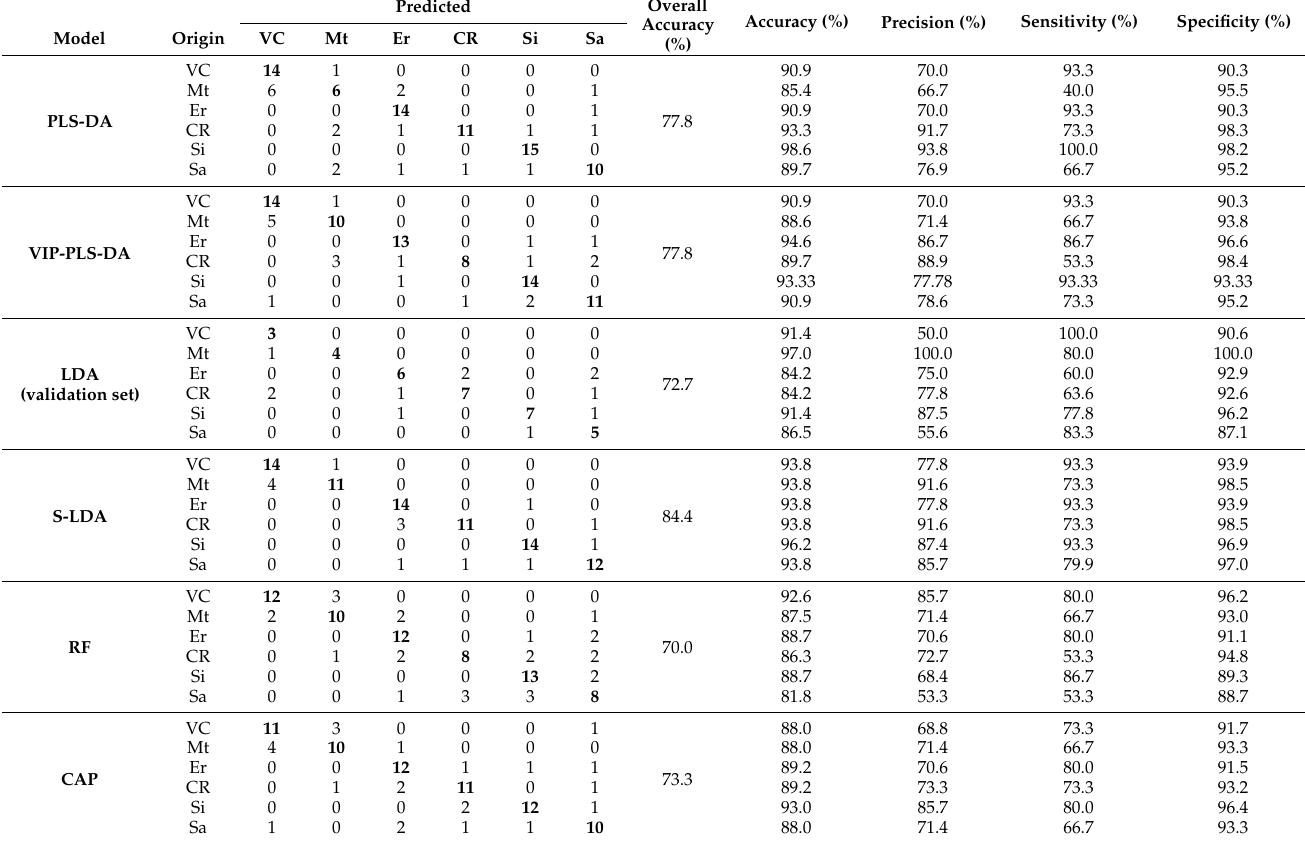
Table 1. Partial least-squares discriminant analysis (PLS-DA), variable importance in projection partial least-squares discriminant analysis (VIP-PLS-DA), linear discriminant analysis (LDA), stepwise linear discriminant analysis (S-LDA), random forests (RF) and canonical analysis of principal coordinates (CAP) confusion matrixes (correctly classified samples in bold) and model performance traits (overall model accuracy and group classification accuracy, precision, sensitivity and specificity), based on the elemental profiles of the individuals collected at Viana do Castelo (VC), Matosinhos (Mt), Ericeira (Er), Cabo Raso (Cr), Sines (Si) and Sagres (Sa) sampling